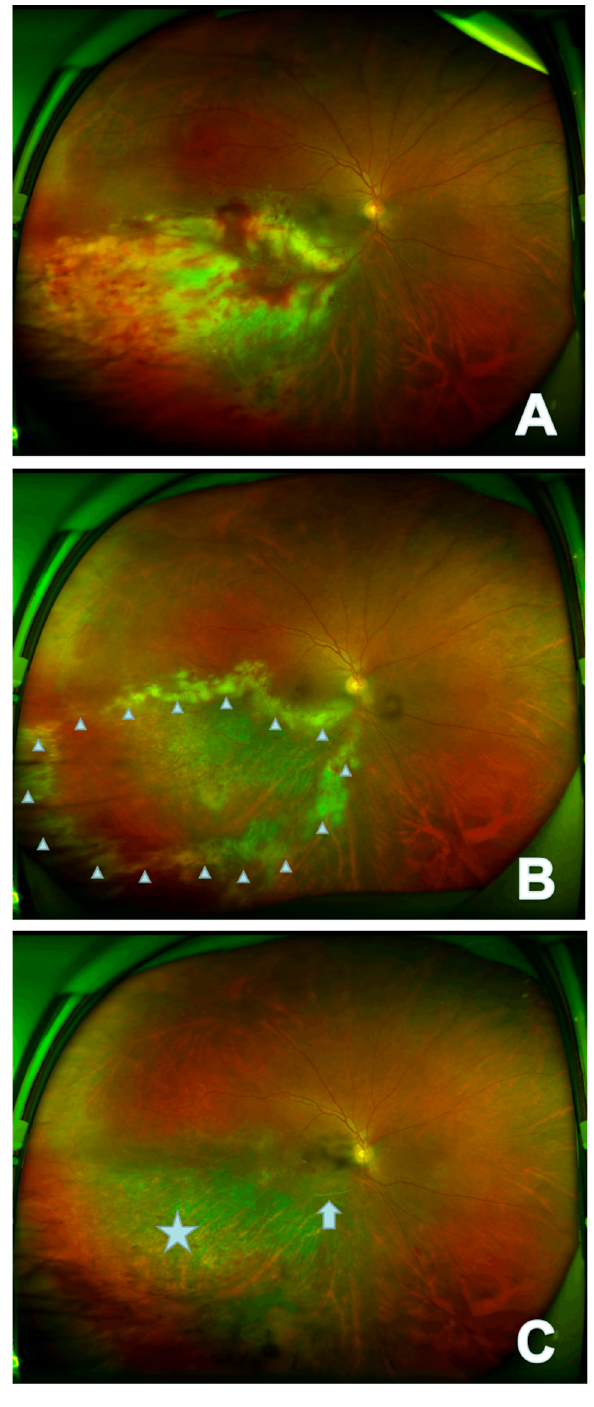
Figure 1. In the right eye of case 6, the lesion appears as fulminant/edematous type. The onset focus of the fundus showed a yellow-white patchy fusion lesion that had formed in the infratemporal branch of the retina with development of retinal hemorrhage ( A ); recurrent fundus mainly manifests as new yellow-white fusion around the original atrophic area ( △ ) ( B ); the stable focus showed gray atrophy of retina ( ☆ ) with local retinal artery occlusion ( ↑ ) ( C ). The p -value of the correlation analysis between the lesion area and the initial visual acuity was 0.064, and the correlation coefficient was − 0.49. The lesion area at recurrence was not related to the age of onset, recurrence interval, visual acuity at recurrence, CD4 + T lym- phocyte count at recurrence, or viral load in aqueous humor at recurrence.